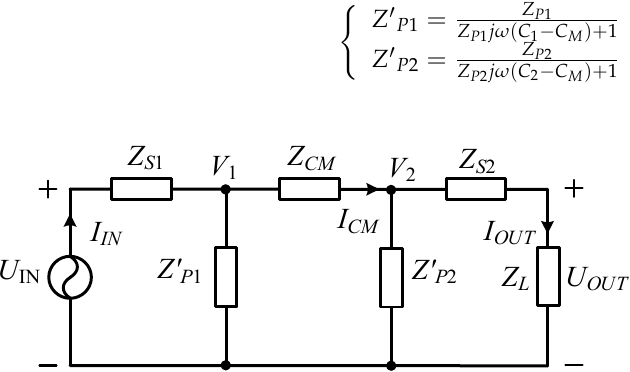
Figure 6. The SP compensation topology with the π -type model of coupler structure.